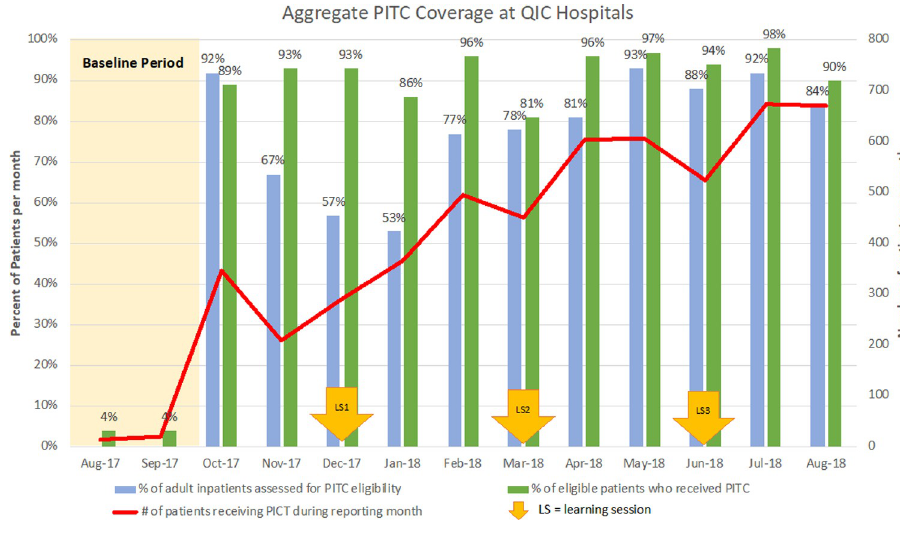
Fig 2. Aggregate PITC